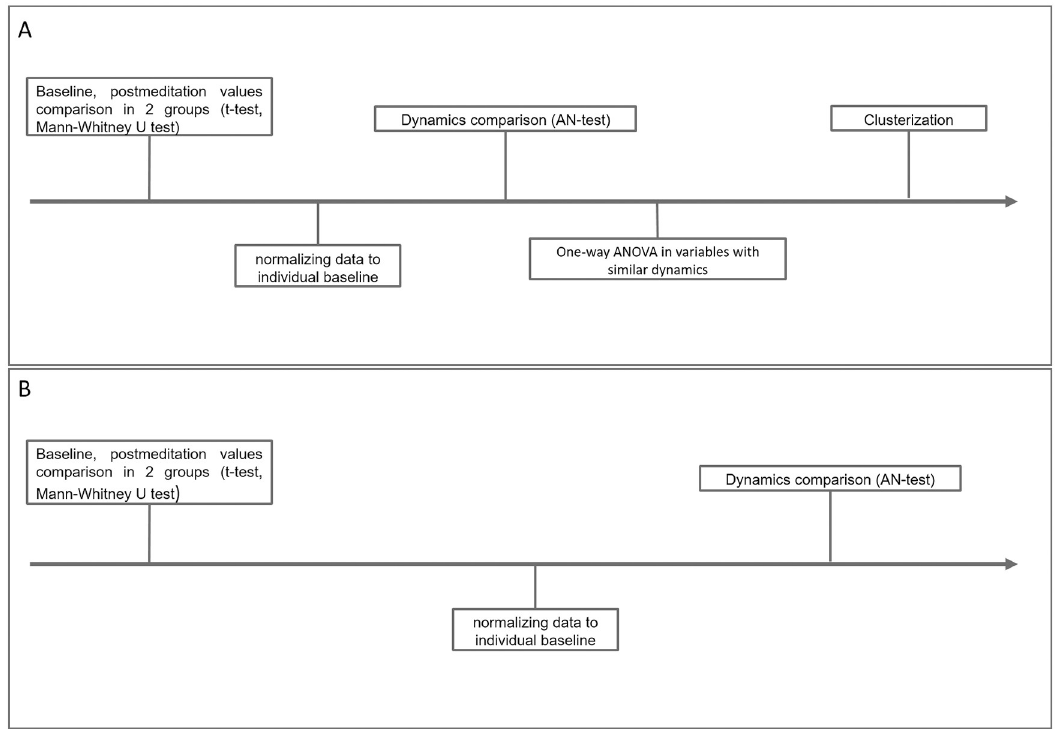
Fig 2. Statistical analysis scheme. (A) Comparison of the experienced meditators and the novices groups. (B) Comparison of two subgroups of the experienced meditators.